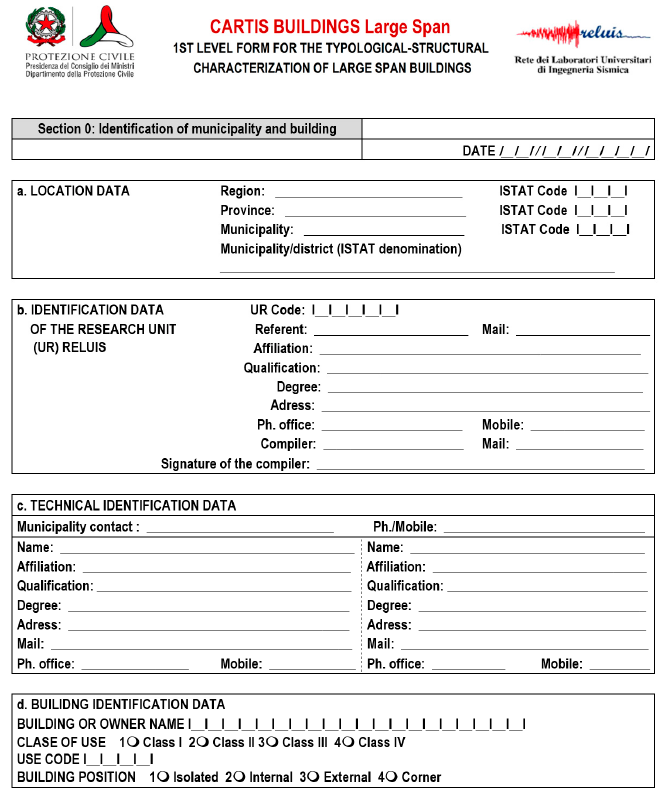
Figure 7. Section 0 CARTIS-Building: Identification of municipality and building (English version [19]).